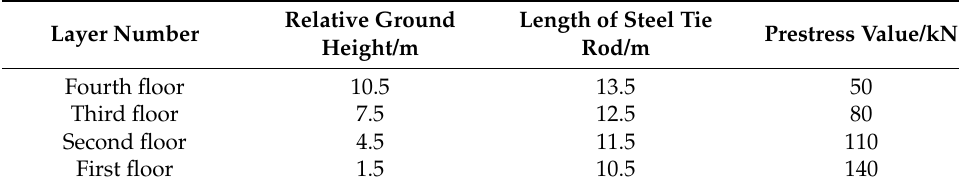
Table 5. Parameters of anchor-plate of example 2.